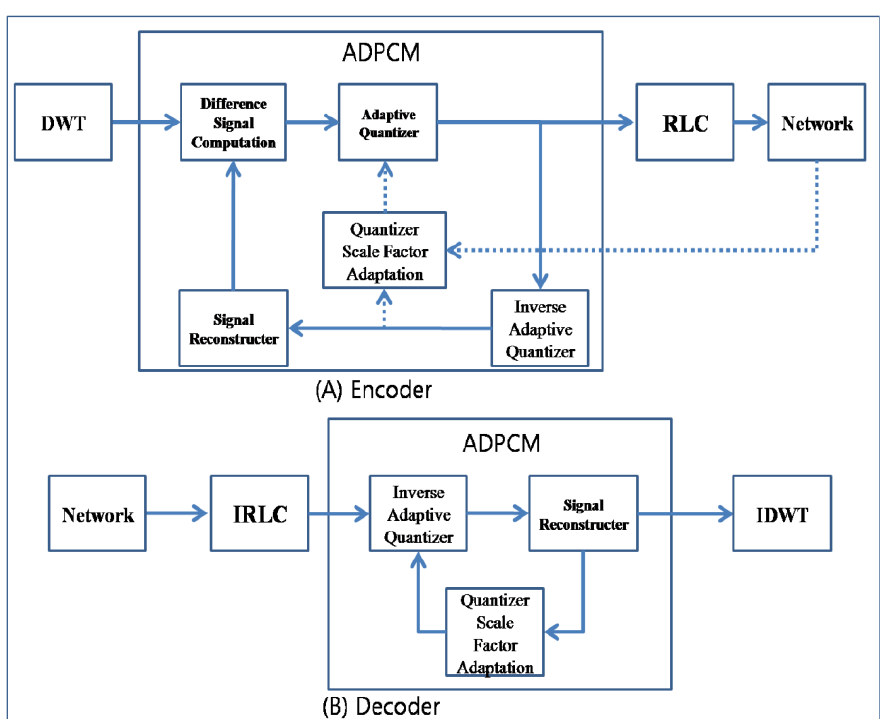
Figure 7. Block schematic of